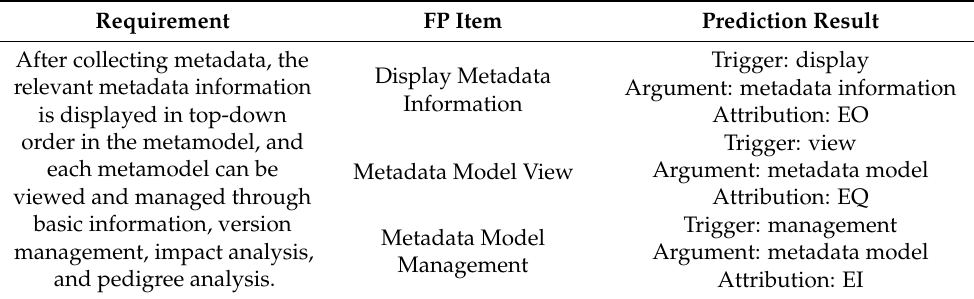
Table 8. Samples of model predictions.